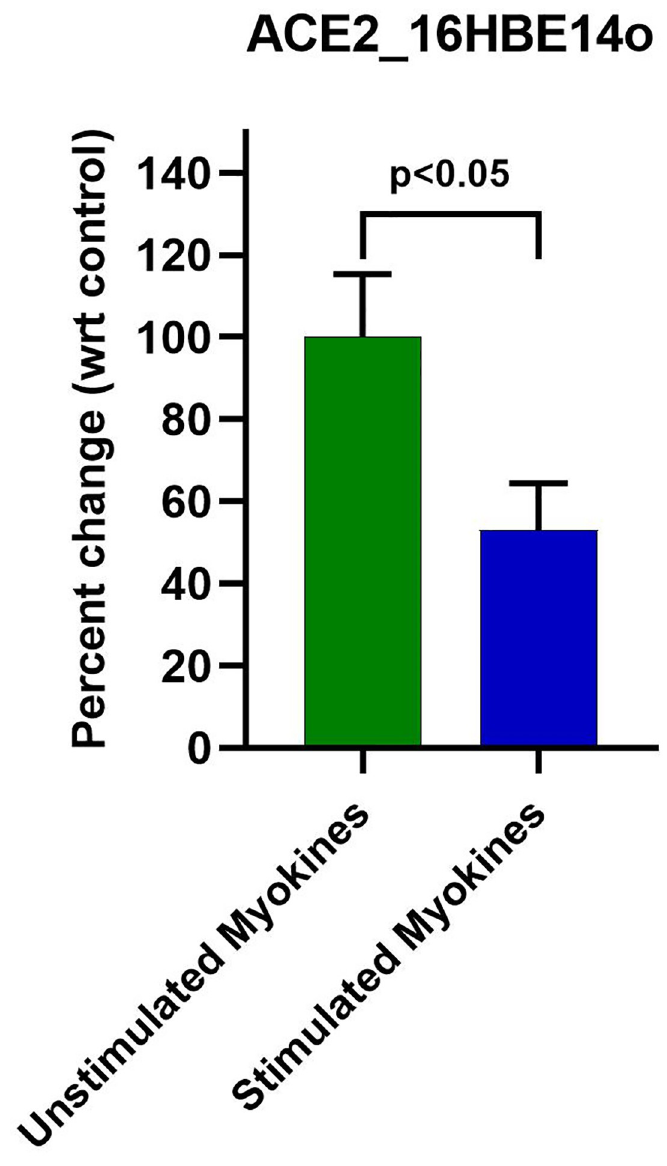
Fig 2. 48 h stimulated myokine treatment downregulated ACE2 protein levels in 16HBE14o. Anti-ACE2 ELISA revealed a ~53.0% downregulation of ACE2 protein with stimulated myokine